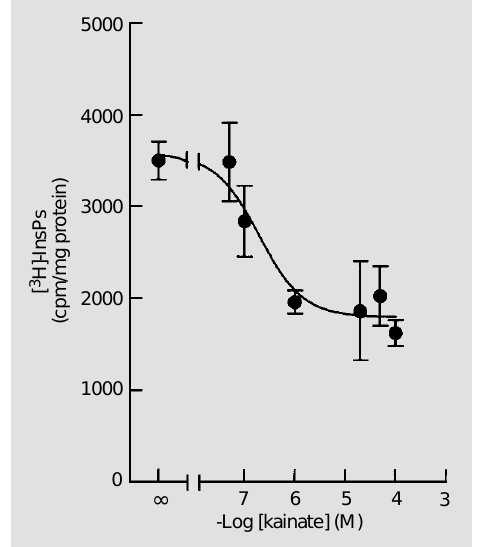
Figure 1 - Effect of increasing concentrations of kainate on the carbachol-induced [ 3 H]-InsPs ac- cumulation in retinas of 14-day- old embryos (E14). Retinas were incubated with 100 µM carba- chol in the absence or presence of the indicated concentrations of kainate. Basal levels: 374.6 ± 41.3 cpm/mg protein. Each point represents the mean ± SEM (er- ror bars) for 2 to 4 separate ex- periments (N = 4 to 8 retinas from different